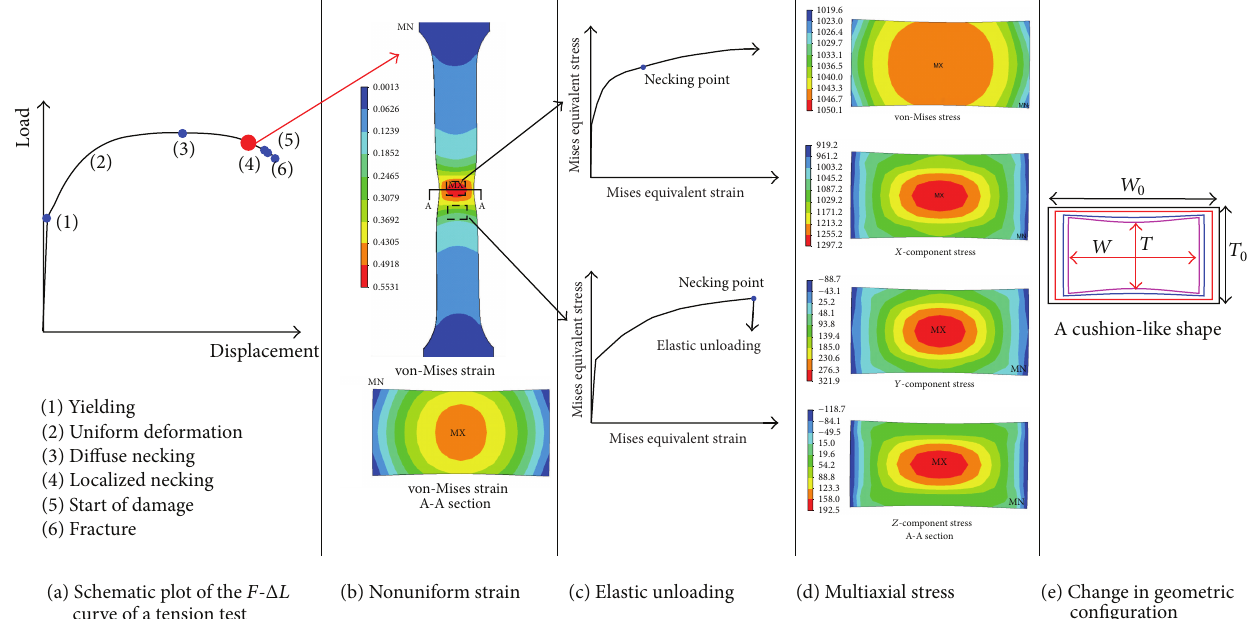
Figure 1: The difficulties in determining the true stress-strain curve at very large strains from uniaxial tensile test.